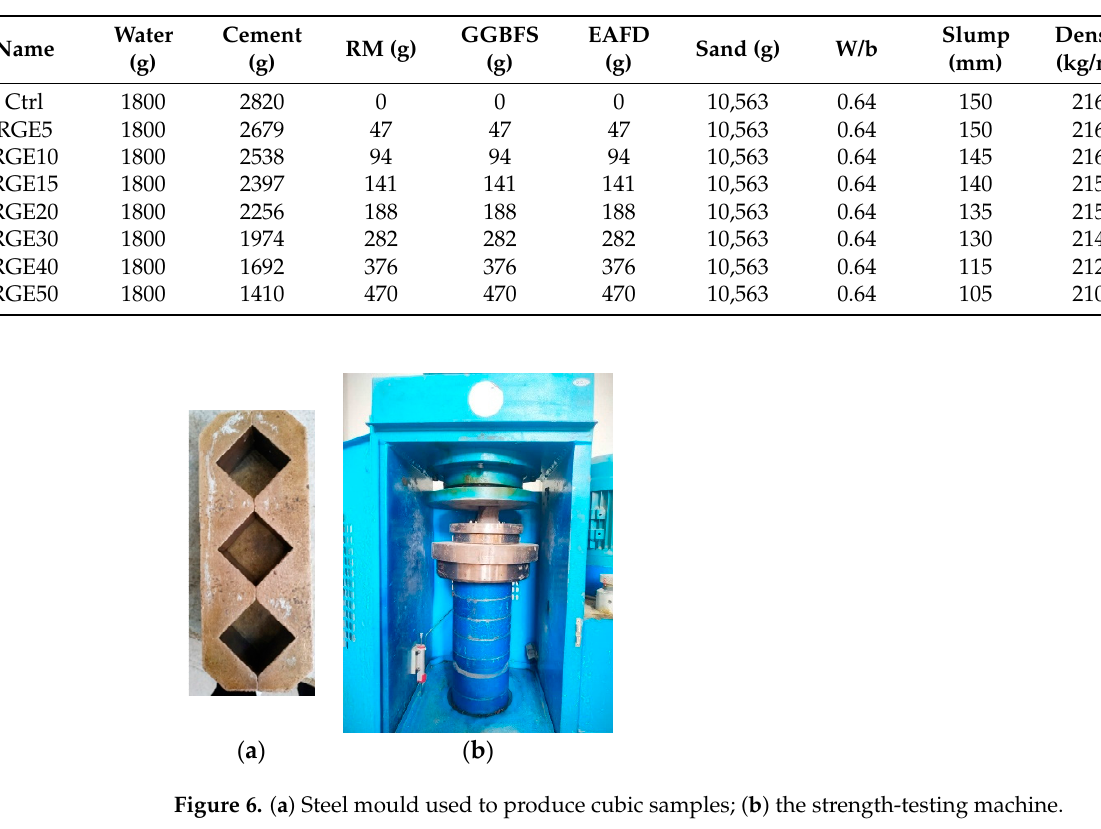
Table 3. Details of tests performed on fresh and hardened